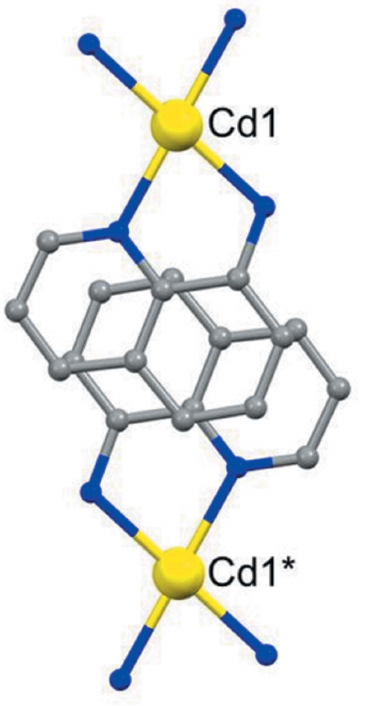
Figure 4 Part of the crystal structure showing the (cid:2) -stacking of quinolin-8-amine ligands. For the sake of clarity, the unit-cell outline and the H atoms have been omitted: the Cd atom marked with an asterisk (*) is at (1.5, 1/2,